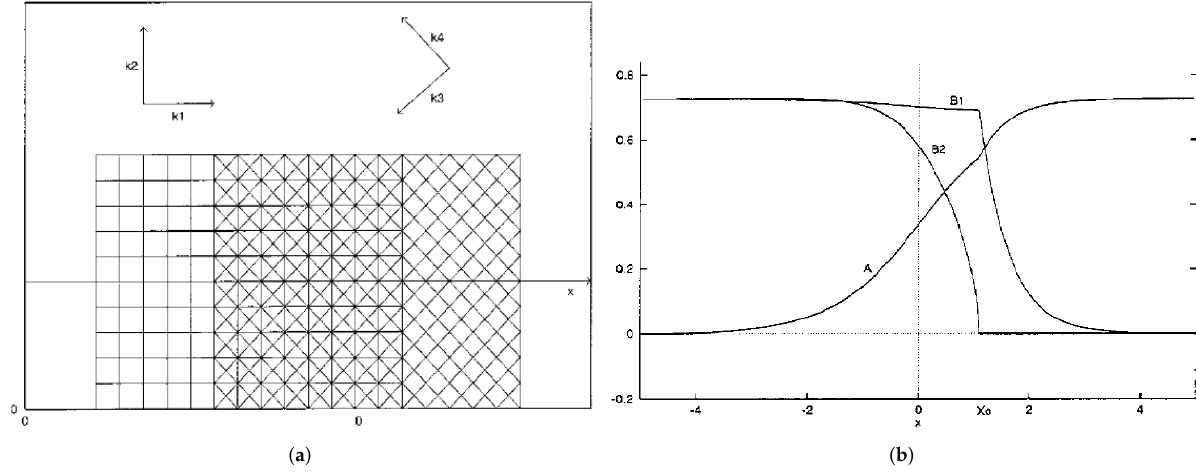
Figure 9. ( a ) The scheme for building a broad stripe of the octagonal quasicrystalline state as a transient layer between semi-infinite domains filled by square-lattice patterns, mutually rotated by 45 o . ( b ) An example of the corresponding solution for amplitudes A ( x ) and B 1,2 ( x ) . Parts of the solution corresponding to Equation (133) or to B 2 = 0 are connected at the stitch point x = x 0 . Reprinted with permissions from Ref.